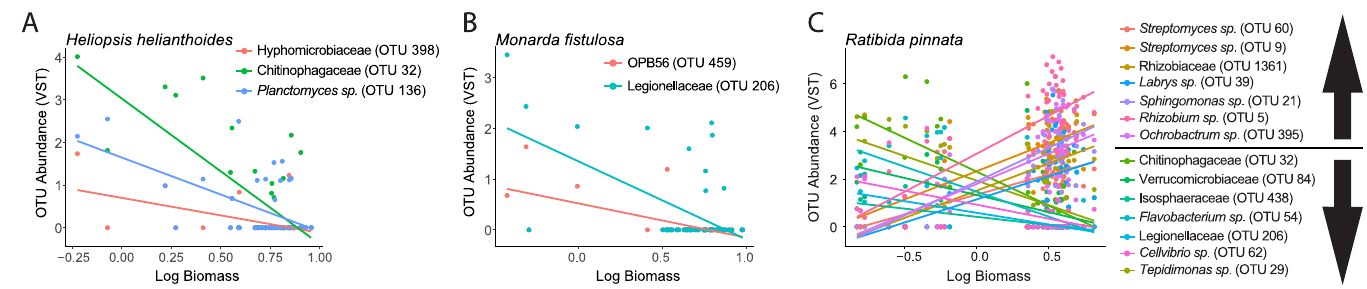
Fig 5. Bacterial species abundance with statistically significant (P � 0.05, after Bonferroni correction) correlation with plant log biomass. Bacterial species within the roots of (A) H . helianthoides (B) M . fistulosa and (C) R . pinnata .